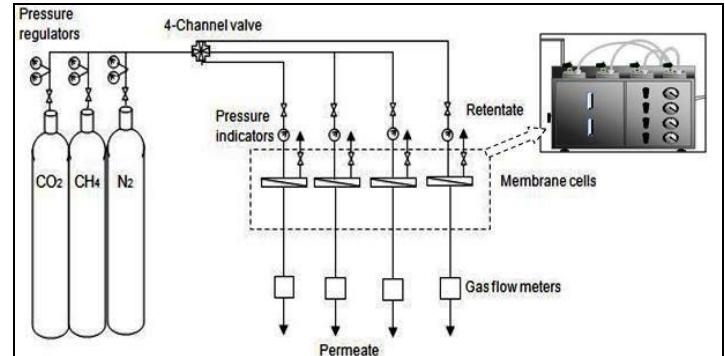
Figure 2. Four channel permeation cell set up.